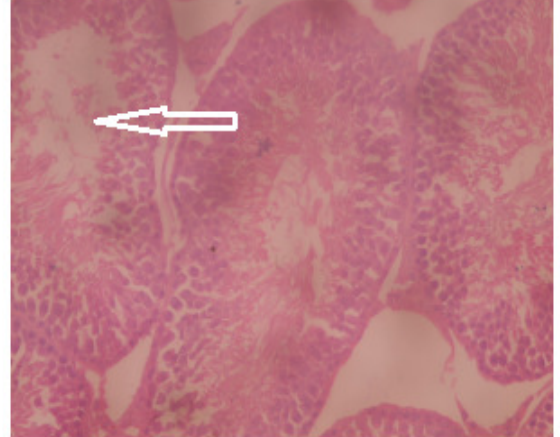
Fig. 3. Photomicrograph of transverse section of typical testicular tissue from group 3 rats (x400 magnification; H&E) Slide shows histologically distorted testicular tissue. Seminiferous tubule contains vacuole with relative absence of mature spermatozoa as compared to Fig. 2